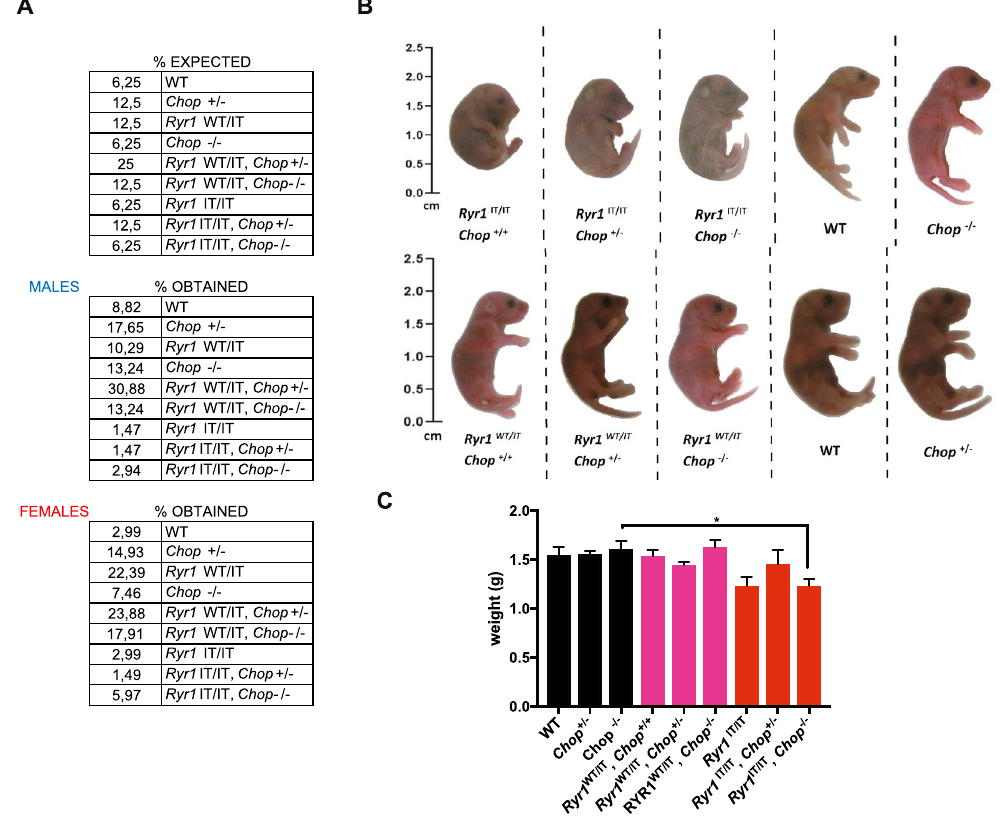
Figure 1. Low recovery rate and gross morphology of Ryr1 I4895T/I4895T , Chop −/− newborn pups. ( A ) The expected and observed distribution of males and females, as percentages of genotypes on day one among a progeny of one hundred thirty-five (sixty-eight males and sixty-seven females) newborns pups from a cross between Ryr1 WT / I4895T , Chop + /− trans-heterozygote female and male mice. ( B ) Representative gross lateral view of newborn pups (the vertical black lines indicate that the views of the pups were trimmed from different snapshots from which the original background was erased and the views of the different pups copied on the same background) of the indicated genotypes. Ryr1 I4895T /I4895T , Ryr1 I4895T/I4895T , Chop + /− Ryr1 I4895T/I4895T , Chop −/− have a curved posture. ( C ) Bar graphs depicting the mean weight of newborn mice at